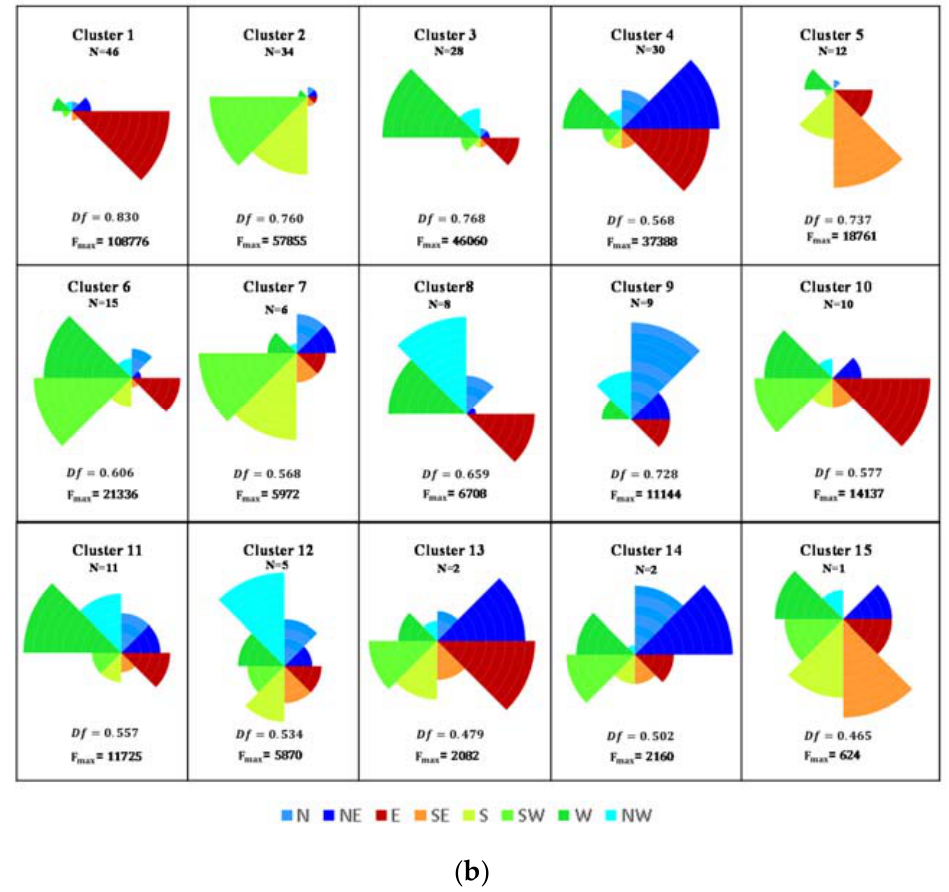
Figure 6. Flow orientation patterns of HIR clusters. ( a ) Morning HIR clusters; ( b ) Evening HIR clusters.